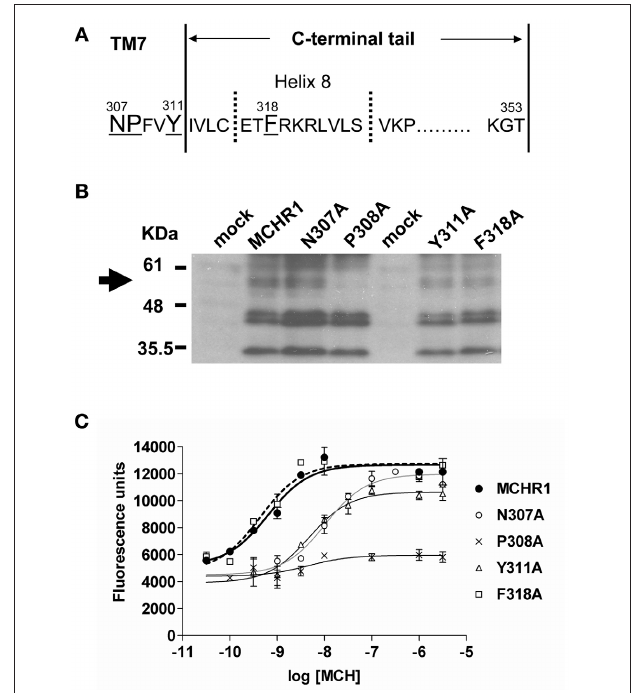
FIGURE 1 | Analysis of the effects of individual substitution mutations in the NPxxY(x) 5 , 6 F motif of MCHR1 on receptor function in HEK293T cells. (A) Schematic representation of the conserved NPxxY(x) 5 , 6 F motif and the C-terminal tail of the rat MCHR1. The C-terminal tail of rat MCHR1 extends 42 residues from the plasma membrane (residue 312–353) and is predicted to include an eighth cytoplasmic helix (helix 8) (Tetsuka et al., 2004). Amino acid residues targeted for mutational analyses are underlined. TM7; transmembrane 7. (B) Protein expression of Flag-MCHR1 and mutant receptors. After lysis of transfected cells with SDS-sample buffer, 15 μ g total protein was separated by 15% SDS-PAGE, transferred to a polyvinyl difluoride membrane, and immunoblotted with an anti-Flag M2 antibody. Four major immunoreactive bands of 35, 44, 45, and 60kDa are present in Flag-MCHR1 and individual mutant receptors. (C) Cells transfected with Flag-MCHR1 or substitution mutant receptors were stimulated with the indicated concentrations of MCH, and the subsequent changes in cytoplasmic free Ca 2 + levels were measured using a FlexStation. Results shown are representative of at least